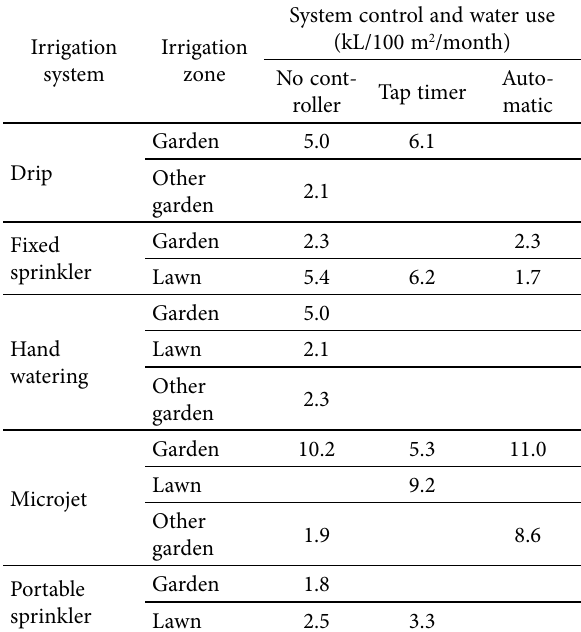
Table 6. Variation of water use with system, system control and irrigation